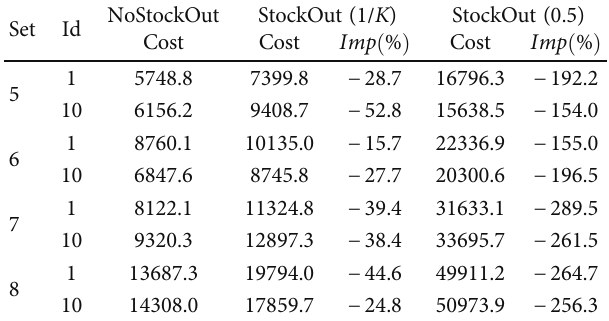
Table 6: Sensitivity analysis on probability of stock out.